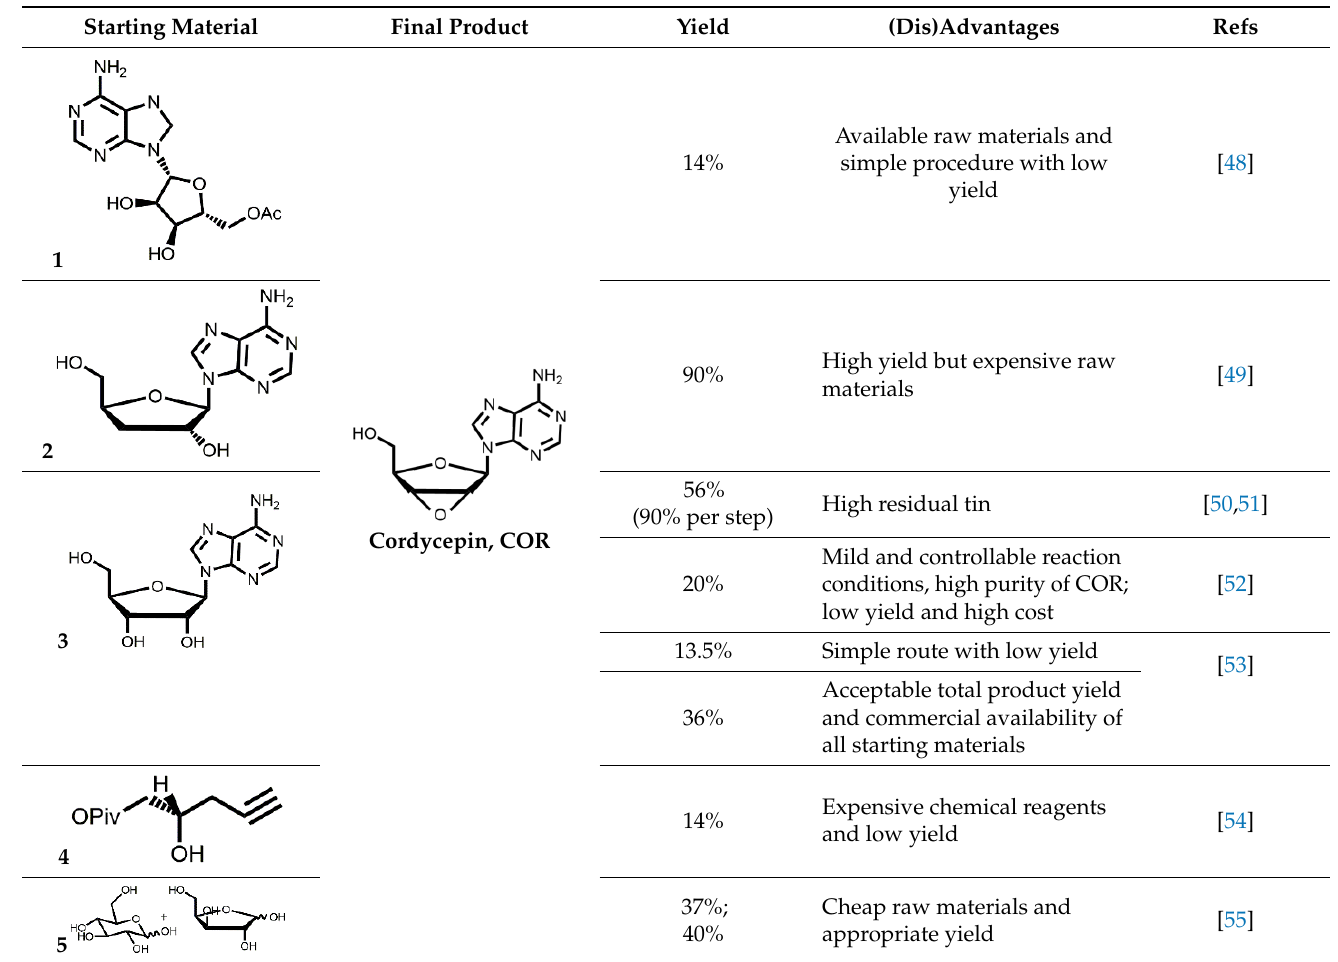
Table 1. The starting materials and yield of chemical synthesis of cordycepin (COR).